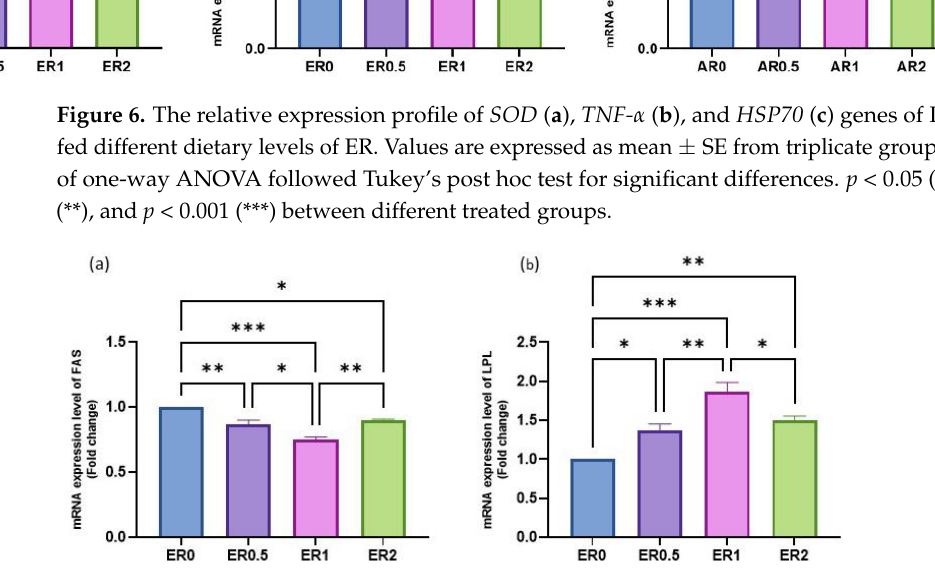
Figure 7. The relative expression profile of fatty acid synthase ( FAS ) ( a ) and lipoprotein lipase ( LPL ) ( b ) genes of Red tilapia fed different dietary levels of ER. Values are expressed as mean ± SE from triplicate groups. p values of one-way ANOVA followed by Tukey’s post hoc test for significant differences between the experimental groups and their control are indicated by asterisks on the data bars when p < 0.05 (*), p < 0.01 (**), and p < 0.001 (***).